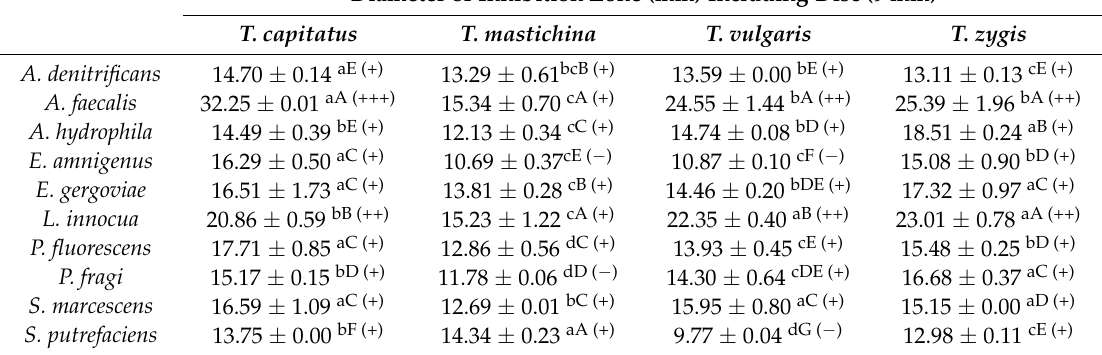
Table 3. Antibacterial activity of T. capitatus , T. mastichina , T. vulgaris and T. zygis EOs against several bacterial strains using cooked ham extract as culture medium.